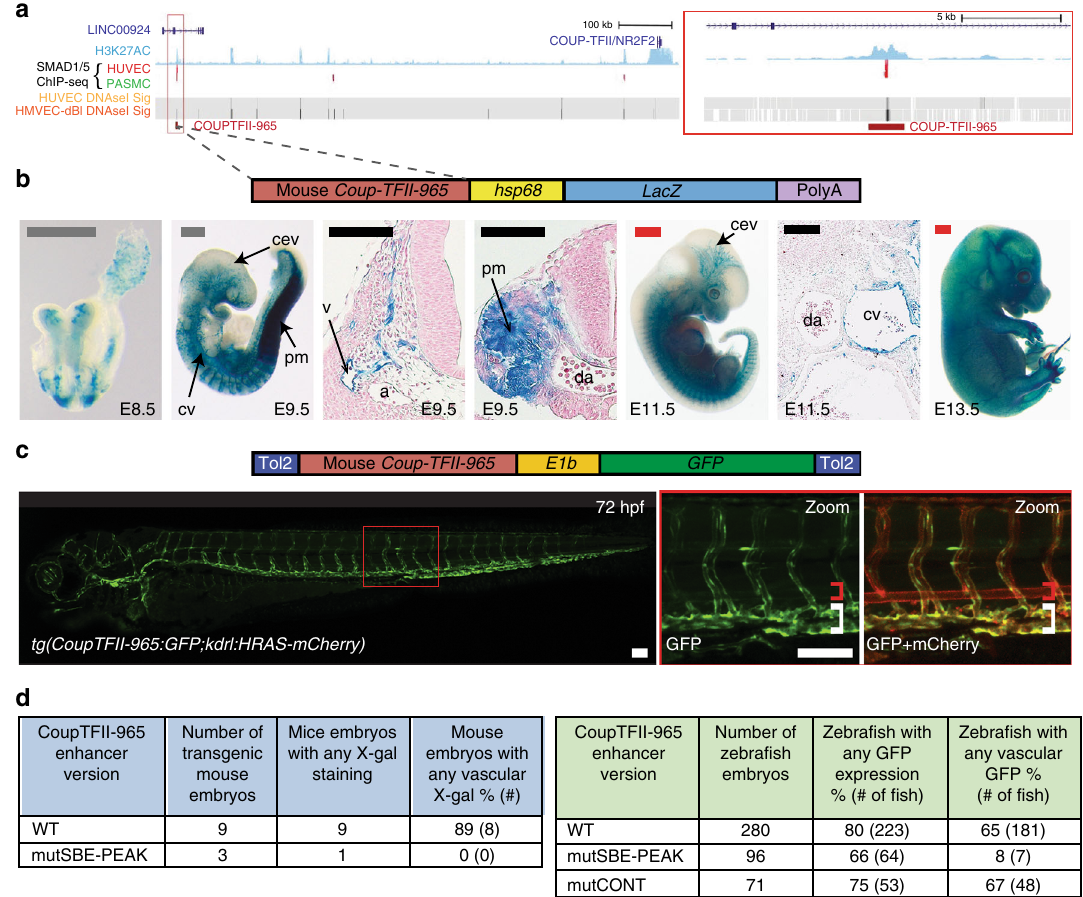
Fig. 7 A SMAD1/5-binding peak identi fi es a vein endothelial enhancer for Coup-TFII . a UCSC browser view (http://genome.ucsc.edu) of COUP-TFII (NR2F2) incorporating SMAD1/5-binding data from Morikawa et al. 32 . A statistically signi fi cant SMAD1/5-binding peak in human umbilical vein endothelial cells (HUVECs) (red) − 965 kb upstream of Coup-TFII correlated with the H3K27Ac enhancer histone mark in HUVECs (blue peaks) and endothelial HUVEC DNaseI hypersensitivity (black heat map). b , c Stable transgenic mouse ( b ) and zebra fi sh ( c ) embryos expressing the lacZ and GFP reporter genes, respectively, under the control of the murine CoupTFII-965 enhancer. In both animal models, enhancer activity was primarily seen in the venous endothelium. Black and white scale bars both represent 100 μ m, grey scale bars are 500 μ m, red scale bars are 1000 μ m. a = artery, v = vein, cev = branches of cerebral venous plexus, cv = cardinal vein, pm = paraxial mesoderm, da = dorsal aorta, red bracket = dorsal aorta; white bracket = posterior cardinal and ventral vein(s). d Tables summarizing reporter gene expression in transient transgenic zebra fi sh and mouse embryos after mutation of